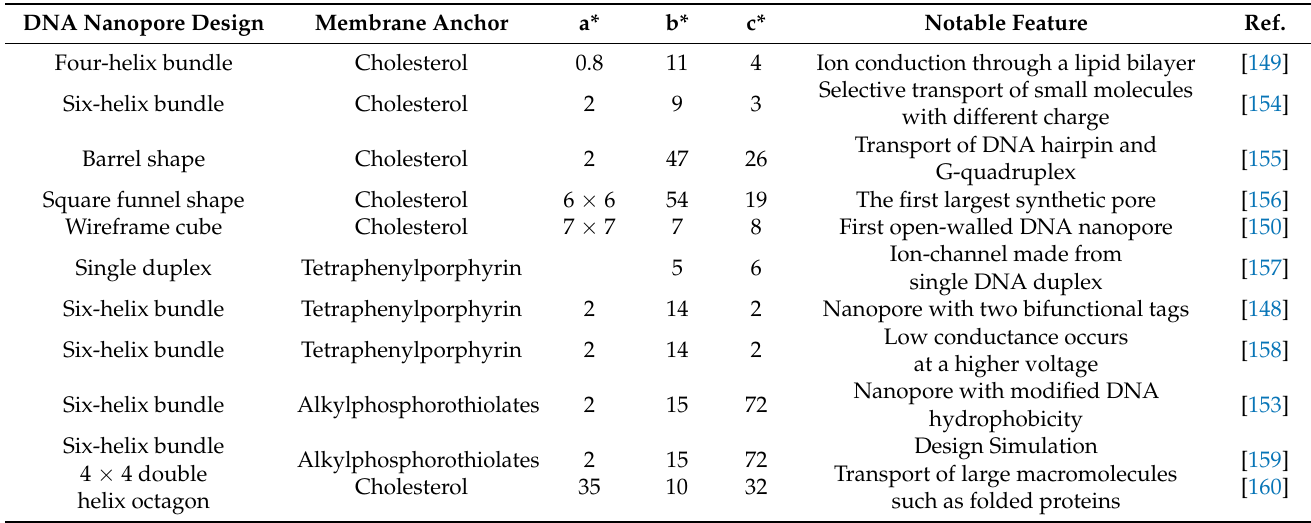
Table 4. Designs and structures of DNA nanopores. DNA Nanopore